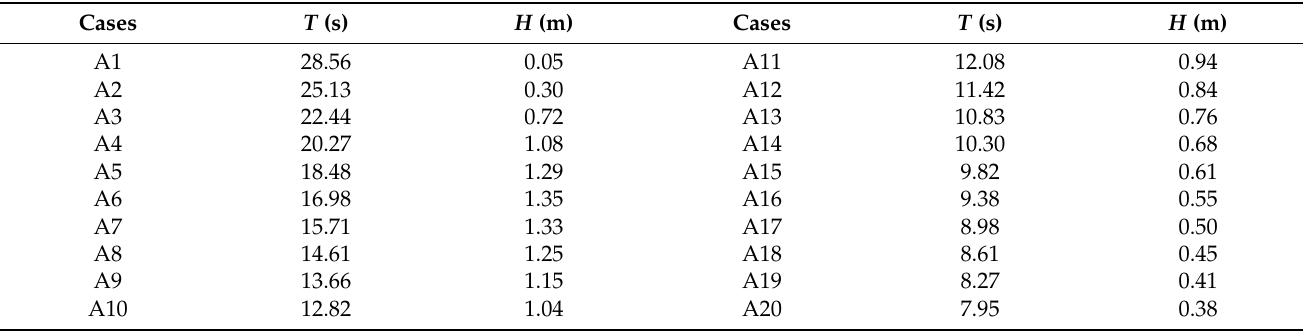
Table 1. The period and wave height of 20 cosine